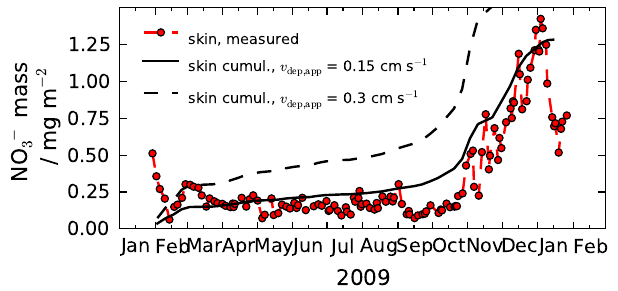
Fig. 7. Cumulative dry deposition from the atmosphere to the skin layer for two different vertical apparent deposition